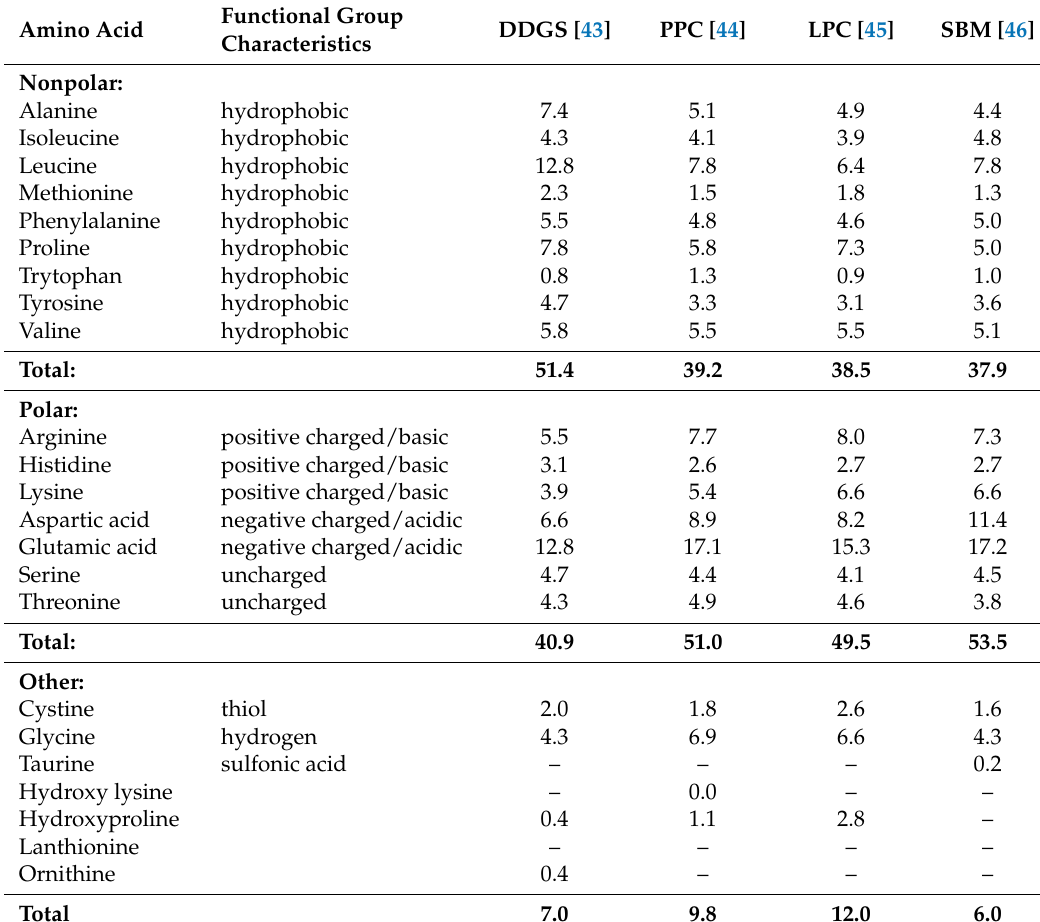
Table 3. Amino acid profiles expressed as percentage of dry matter of the crude protein for untreated DDGS, PPC, and LPC compared with